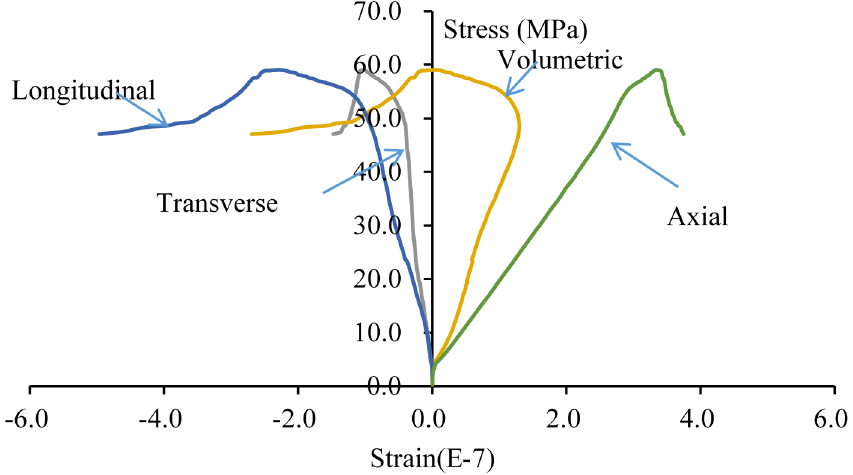
Figure 10. The complete stress-strain curve of the double-fissured specimen under uniaxial compression under fissure water pressure (3.5%  α